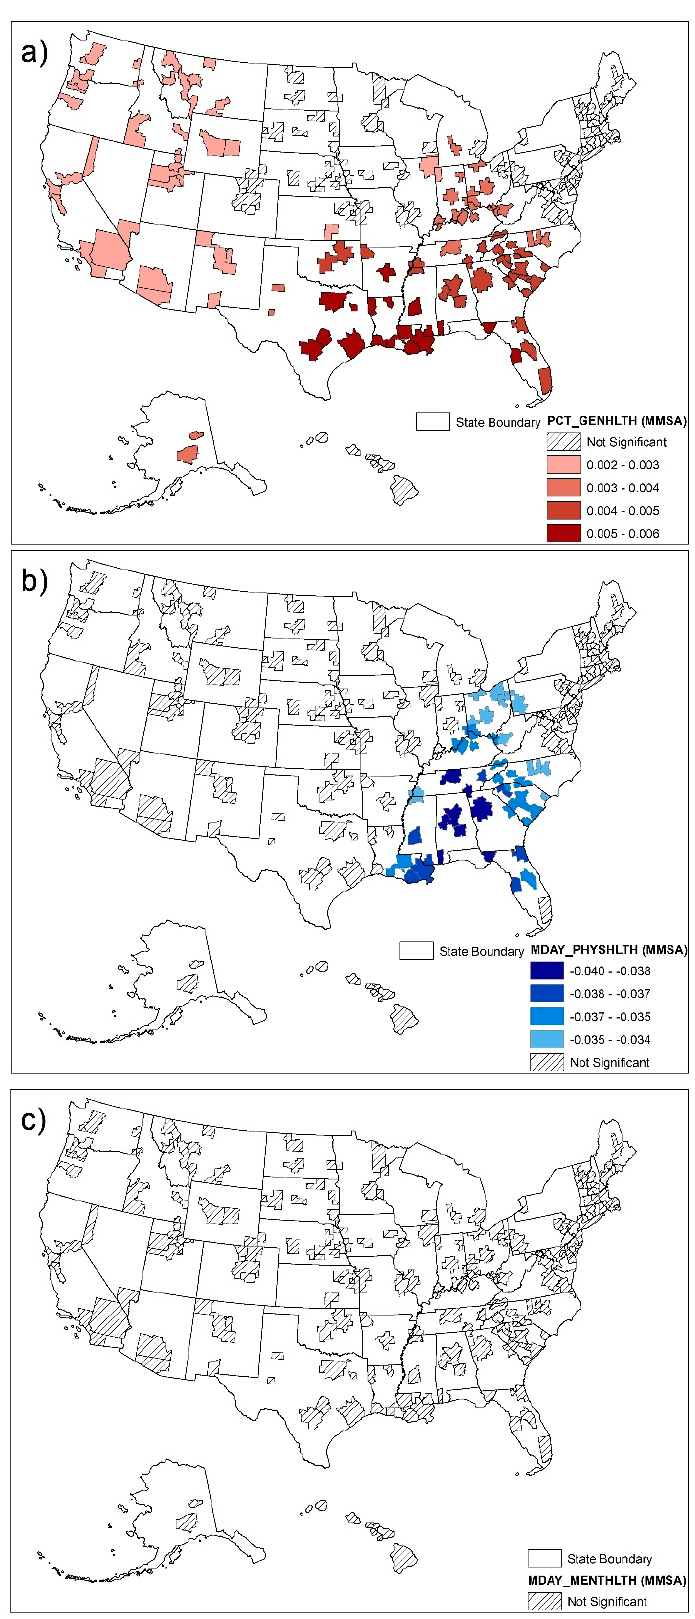
Figure 3. Local associations between MMSA-level age segregation and self-rated health in American older adults, controlled by the total area, poverty, and education levels. ( a ) PCT_GENHLTH , ( b ) MDAY_PHYSHLTH , and ( c ) MDAY_MENTHLTH